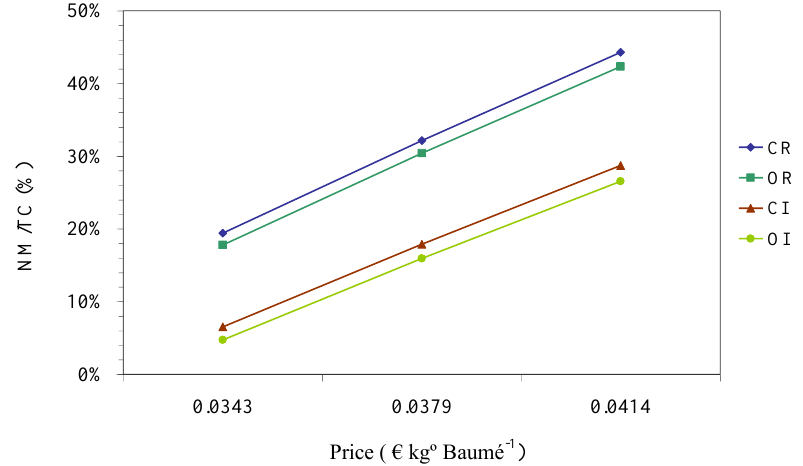
Figure 1. Evolution of profitability based on premiums for quality.